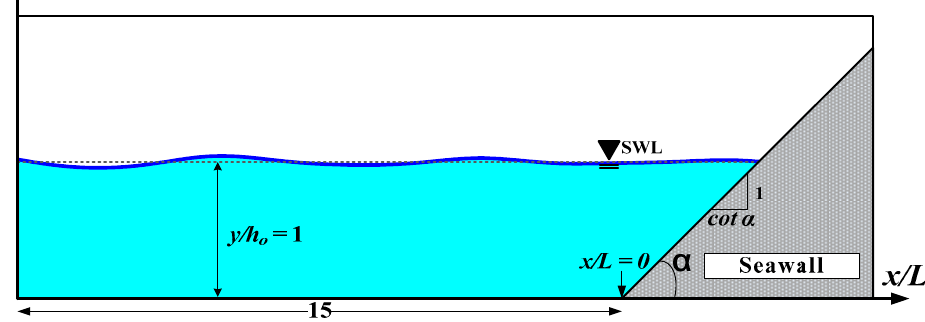
Figure 5. Sketch of the numerical wave tank with a slope-type seawall. Appropriate simulation resolution can be obtained with different grid spacings while reducing computation time. As shown in Figure 6, non-uniform and staggered grids were adopted in the computation domain. To precisely capture the variations in the boundary layer flow, mesh refinement was performed near the bottom for a 16-times boundary- layer thickness ( δ ). There were 30 grids from y / h o = 0 to y / h o = 3 δ / h o , 15 grids from y / h o = 3 δ / h o to y / h o = 6 δ / h o , and 10 grids from y / h o = 6 δ / h o to y / h o = 16 δ / h o . The boundary-layer thickness, δ , was defined as: